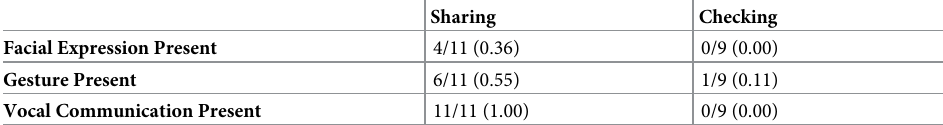
Table 5. The proportion of high agreement Sharing and Checking looks (as judged by the raters) in which the mother produced at least one facial expression, gesture, or vocal communication during their infant’s look to them.